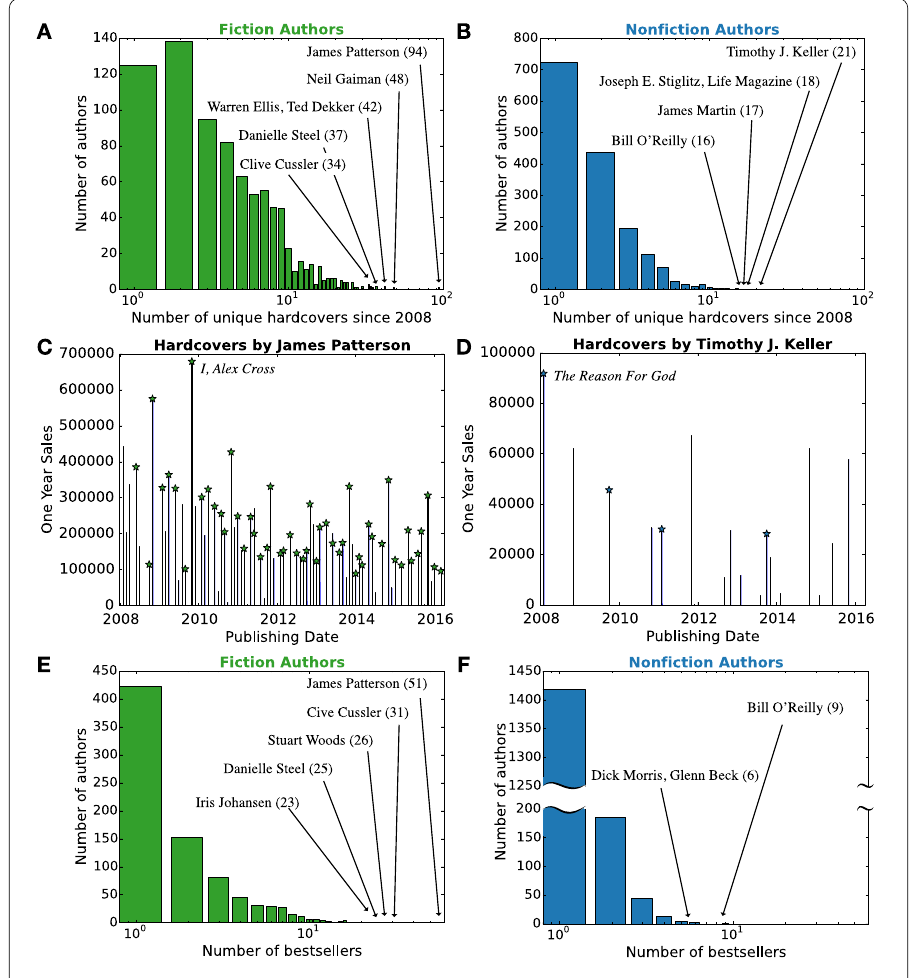
Figure 5 Productivityandrepeatsuccess . The number of unique hardcovers published by ( A ) fiction and ( B ) nonfiction authors since 2008, including their bestsellers. Books published by ( C ) James Patterson and ( D ) Timothy J. Keller, the line height indicating one year sales and stars marking bestseller status. The number of ( E ) fiction and ( F ) nonfiction bestsellers per author. While most authors in both fiction and nonfiction